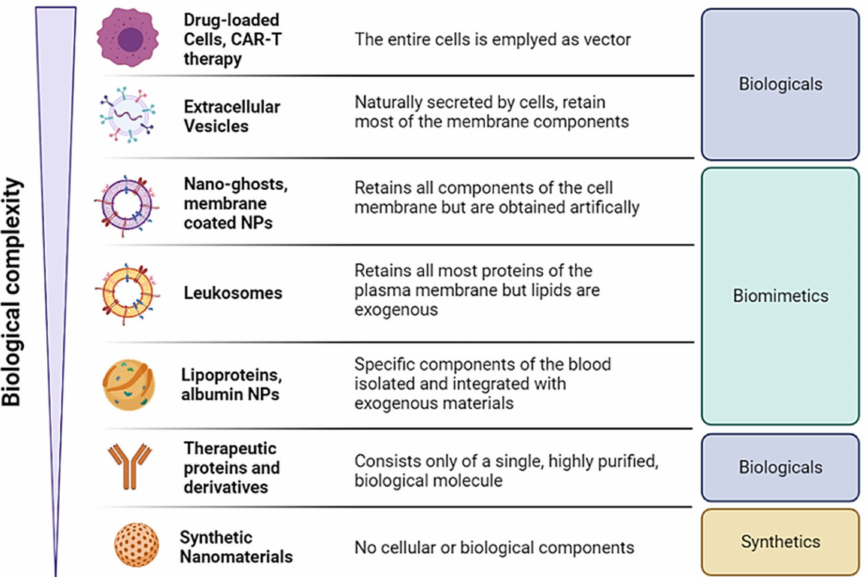
Figure 3. Schematic representation of biological therapies classified based on their resemblance to actual cells. This figure was produced using Biorender.com (accessed on 1 March